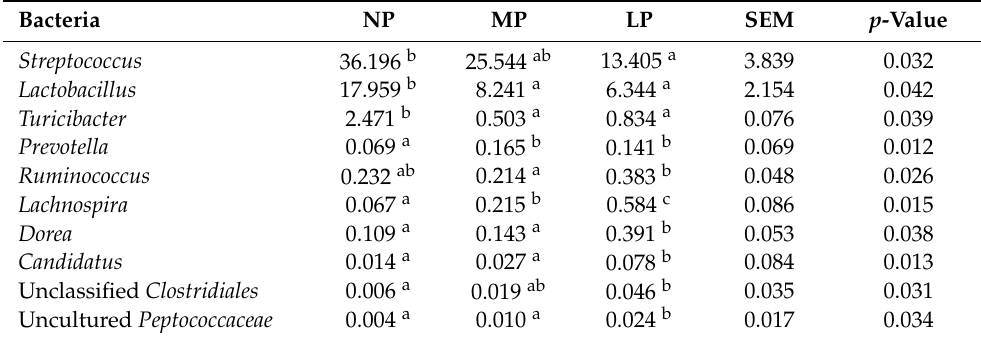
Table 6. The affected microbial genera in the colonic luminal contents of pigs fed different dietary Table 6. The a ff ected microbial genera in the colonic luminal contents of pigs fed di ff erent dietary protein levels, %. protein levels, %.